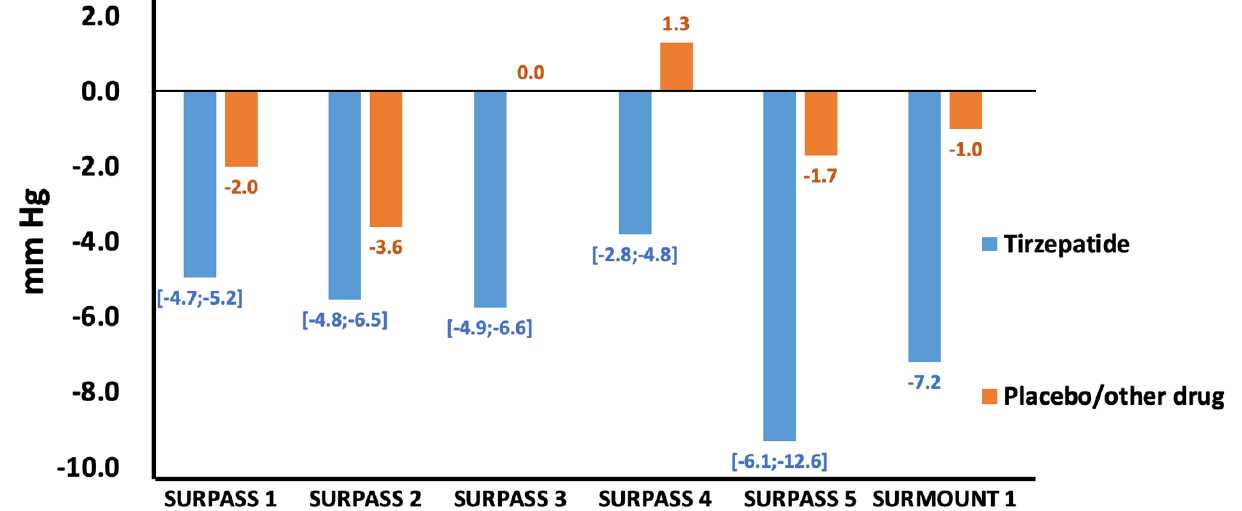
Figure 2. Mean variations in systolic blood pressure (SBP) with Tirzepatide vs. placebo/other drugs in the SURPASS-1 [38], SURPASS-2 [41], SURPASS-3 [44], SURPASS-4 [52], SURPASS-5 [56], and SURMOUNT-1 [66] clinical trials.